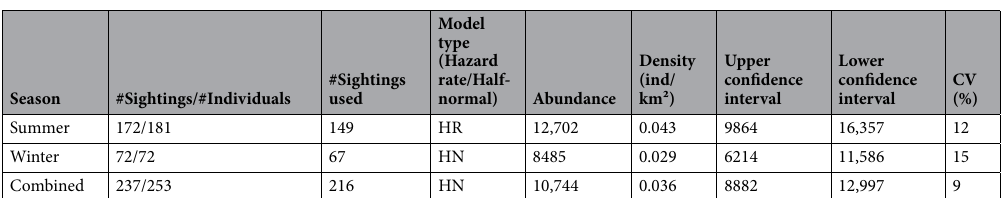
Table 1. Design-based abundance and density estimate results for sunfish with confidence intervals and coefficients of variation (CV) in each